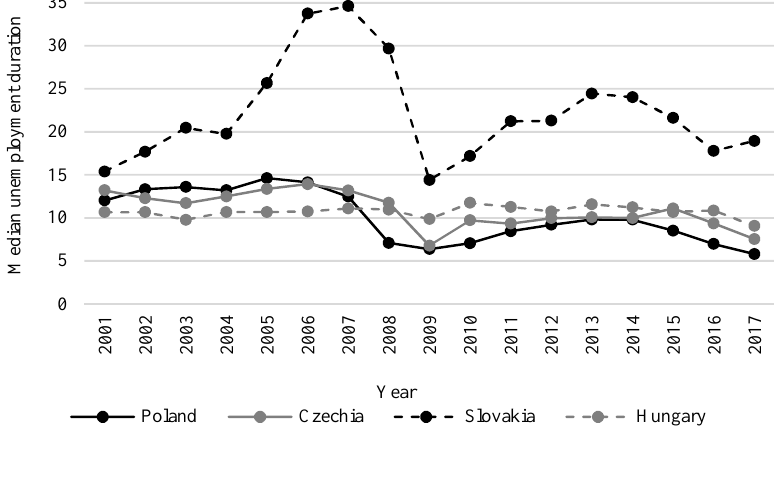
Figure 2. Median unemployment duration (months) in the Visegrad Group countries in years 2001–2017